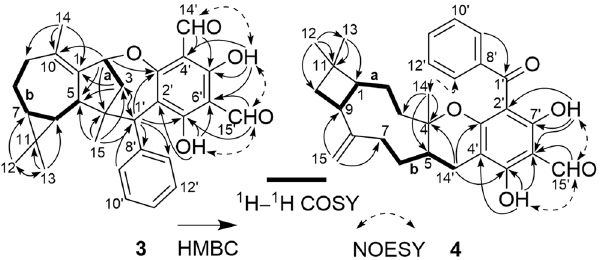
Figure 6. Selected 1 H– 1 H COSY, HMBC, and NOESY correlations of 3 and 4 .